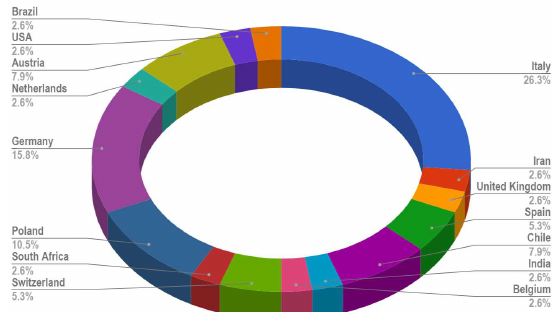
Figure 9. Distribution of participants’